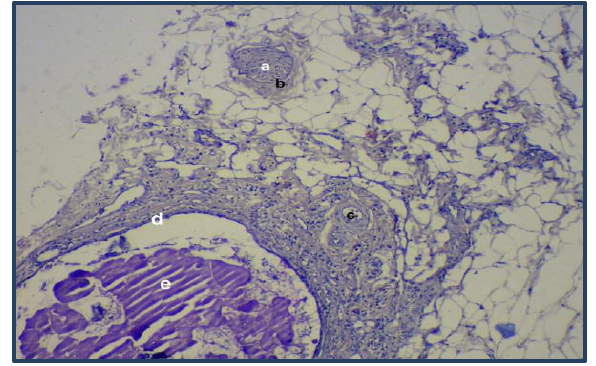
Figure, 15: Ultimobranchial gland shows: a-Accessory parathyroid nodule b- capsule c- Blood vessels d- Cystic structure e- Colloid secretion. (PAS stain, 10